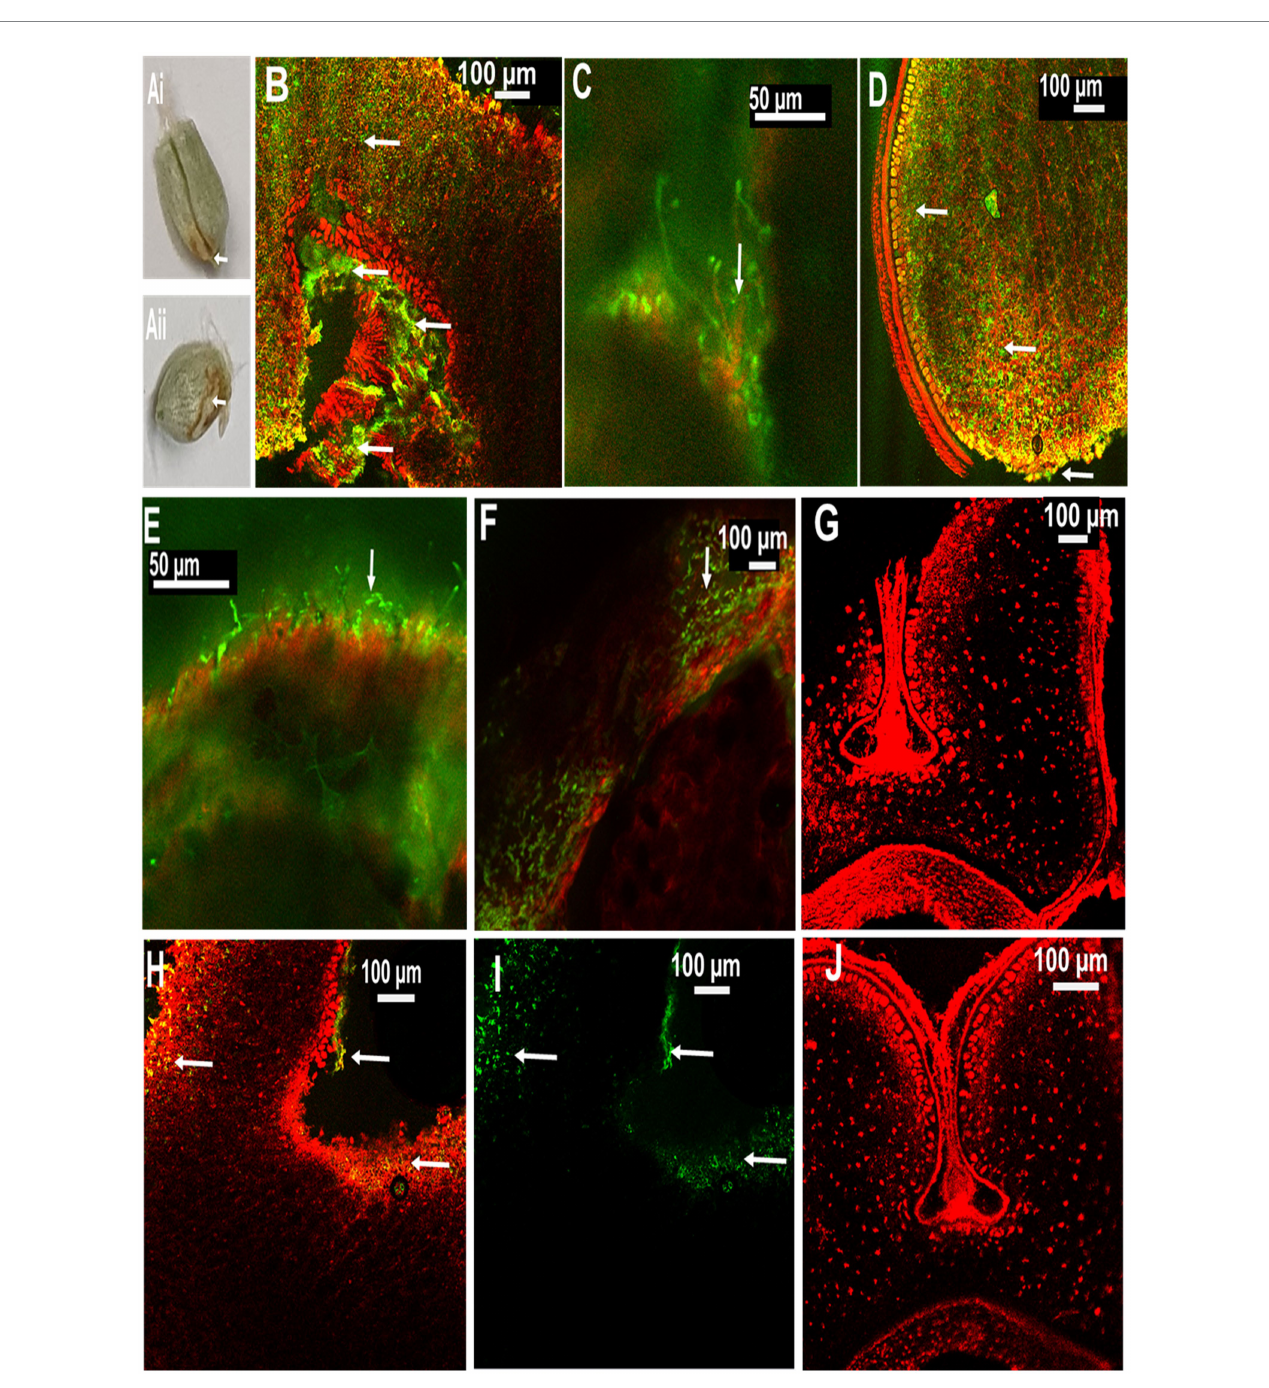
FIGURE 5 Localization of MoT on wheat seeds by confocal laser scanning microscopy (CLSM) using Alexa Flour 488 (AF), staining fungal material green and Propidium Iodide (PI) staining plant tissue red. (A) Seeds of wheat cv. Sumai 3 infected with MoT, where (Ai) inoculated at mid flowering stage, GS 65 and sampled at 10 dpi and (Aii) inoculated at the end of flowering stage, GS 69 and sampled at 10 dpi. (B) Overlay image of a cross-section of the germ region of an infected Sumai 3 seed (inoculated at GS 65 and sampled at 14 dpi). (C) MoT hyphae in germ endosperm (enlarged view from B ). (D) Cross-section of MoT infected caryopsis of Sumai 3 (infected at seed coat region) (inoculated at GS 69 and sampled at 10 dpi); (E) MoT hyphae in the caryopsis coat tissue of Sumai 3 (inoculated at GS 69 and sampled at 10 dpi). (F) MoT hyphae within seed pericarp and testa region (enlarged view from B ). (G) Cross-section of Sumai 3 healthy caryopsis. (H) Overlay image of a cross-section of the germ region of infected Milan seed (inoculated at GS 65 and sampled at 14 dpi). (I) MoT hyphae in infected Milan caryopsis germ region-single channel excitation (inoculated at GS 65 and sampled at 14 dpi). (J) Cross-section of a healthy caryopsis of Milan. The scale bar of images (B,C,E) is 50 μ m, and the rest is 100 μ m. White arrows indicate presence of MoT